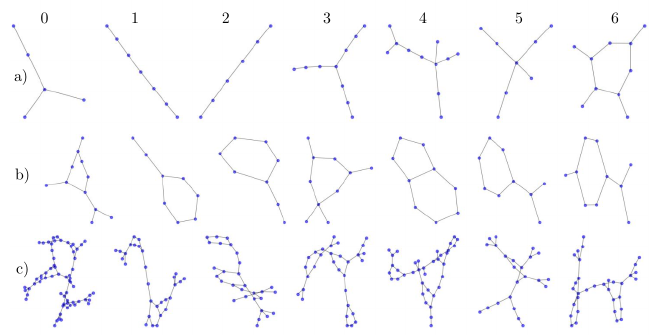
Figure A3. Six nearest neighbors of graphs in latent space from PTC for six graphs. Column 0 correspond to the randomly chosen graph then the six nearest neighbors are draw in increasing distance order from left to right (from 1 to